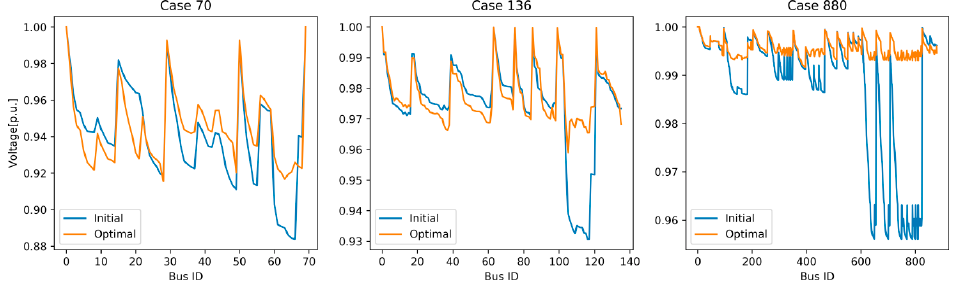
Figure 7. Network voltage profile for initial and optimal network topology.